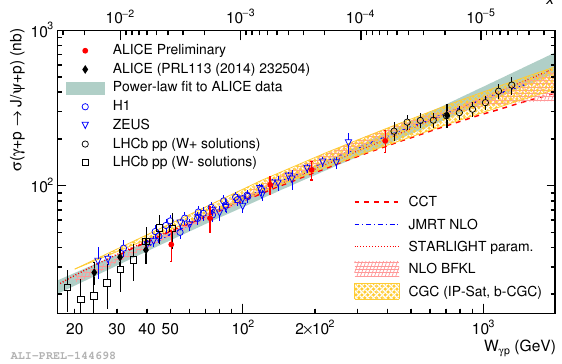
Figure 2. ALICE data on exclusive photoproduction of J /ψ o ff protons as a function of the center- of-mass energy of the photon-proton system in p–Pb collisions at power-law fit, to data from HERA, to the solutions from LHCb and to theoretical models